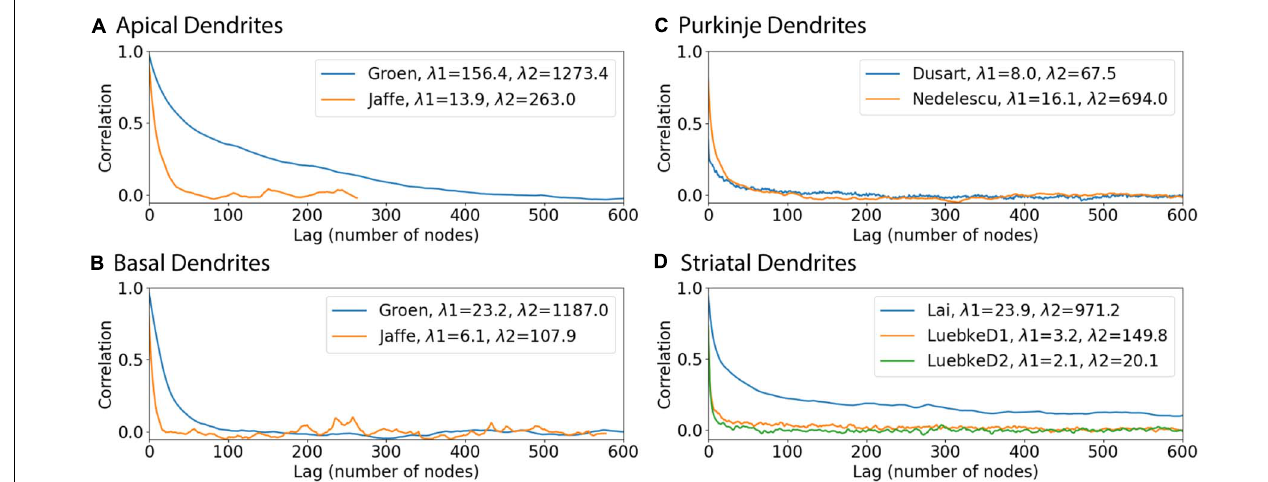
FIGURE 8 | Autocorrelation functions illustrate why predictions of diameter are better for some dendrites. In each archive, the autocorrelation was averaged across morphologies to reduce noise, and then the average autocorrelation was fit to a double exponential decay. (A) Hippocampal apical dendrites, (B) Hippocampal basal